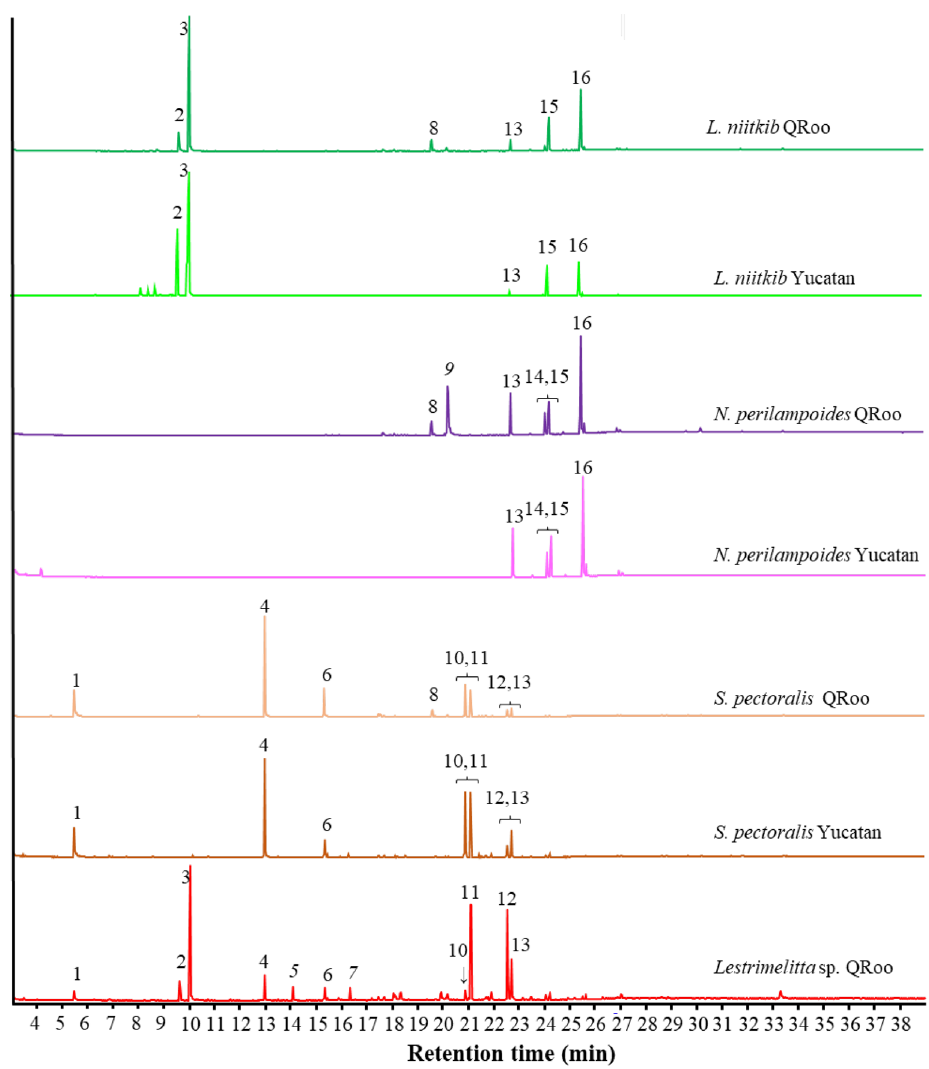
Figure 1. Typical GC/MS chromatograms of cuticular extracts of stingless bee species and localities from the Yucatan Peninsula. (1) benzaldehyde, (2) Z-Citral, (3) E-Citral, (4) 2-tridecanone, (5) not identified, (6) 2-pentadecanone, (7) not identified, (8) methyl octadecanoate, (9) not identified, (10) tricosene, (11) tricosane, (12) pentacosene, (13) pentacosane, (14) heptacosene, (15) heptacosane, (16)